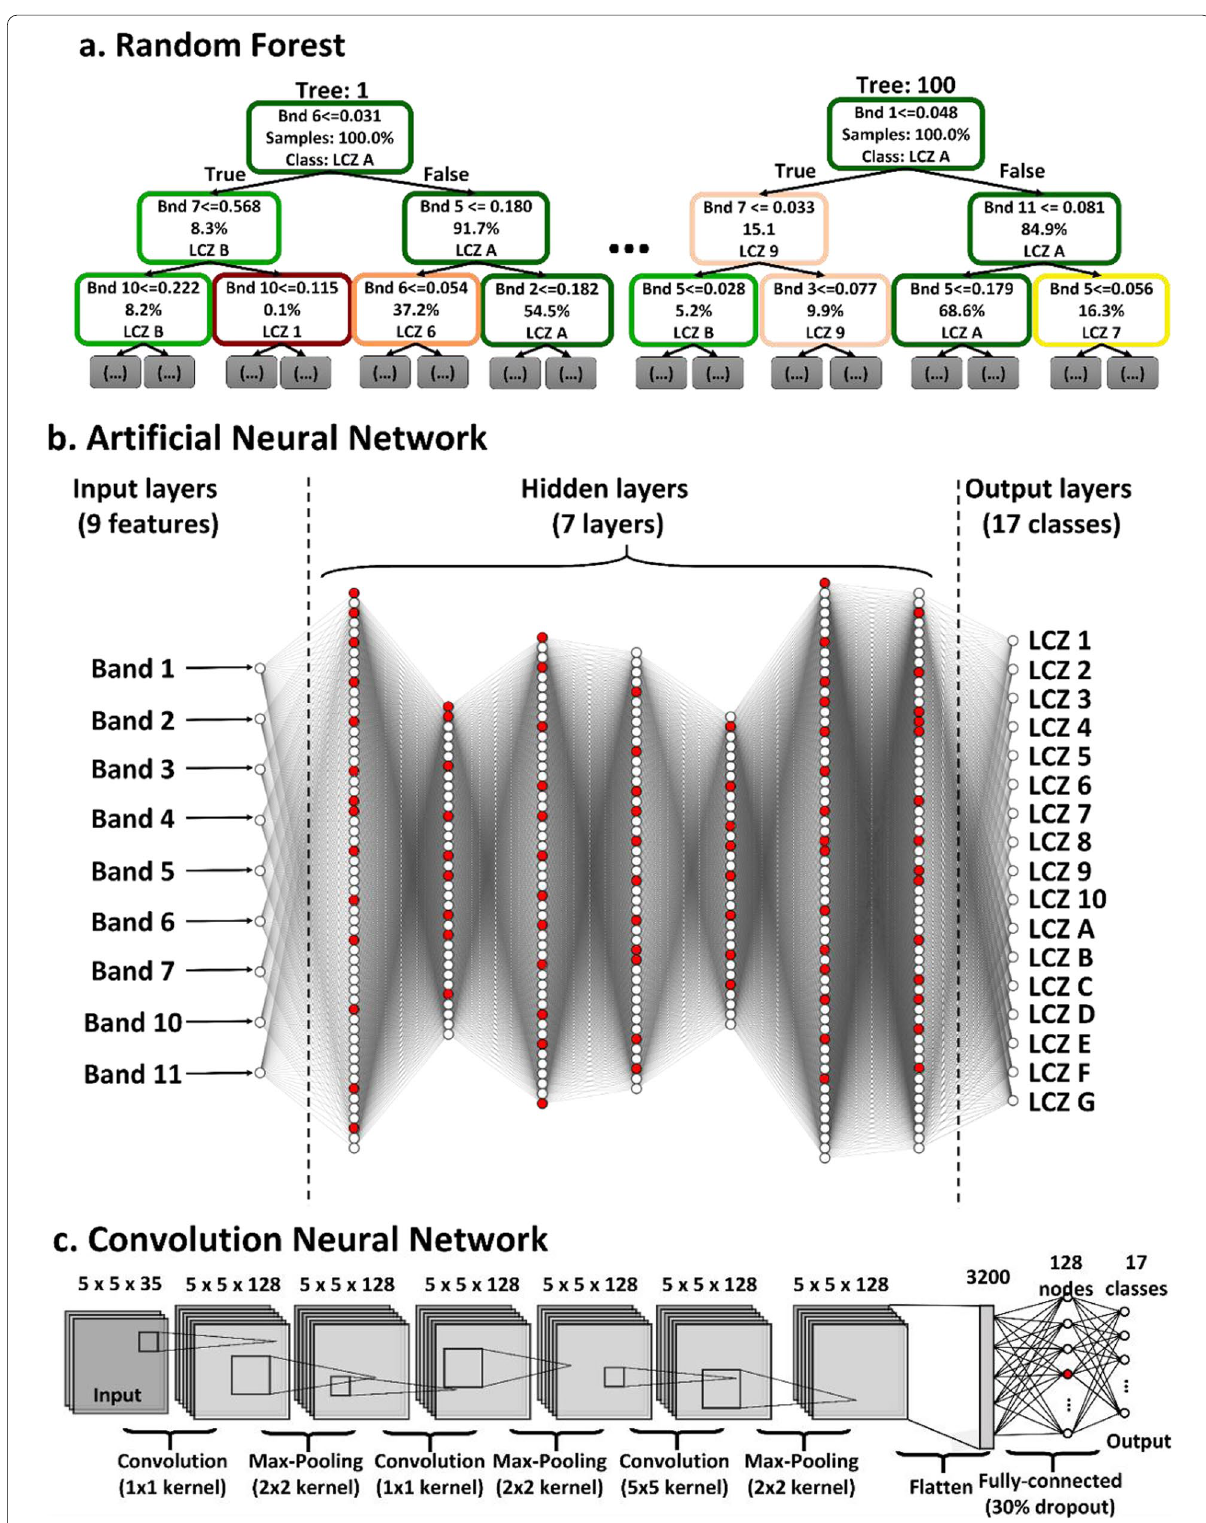
Fig. 4 The architecture of a random forest (RF), b artificial neural network (ANN), and c convolution neural network (CNN) classifier used in this study. Red circles in ANN and CNN denote the dropout